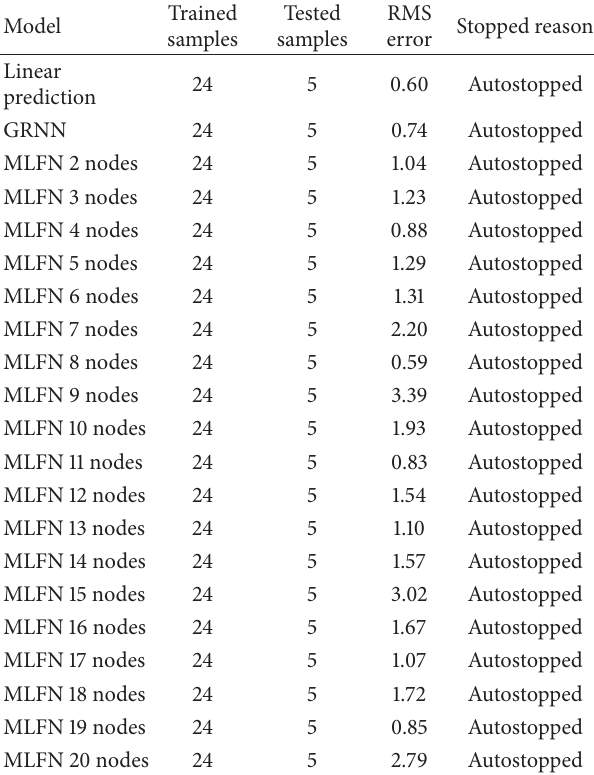
Table 2: Results of different models in analyzing oil content of rapeseed.